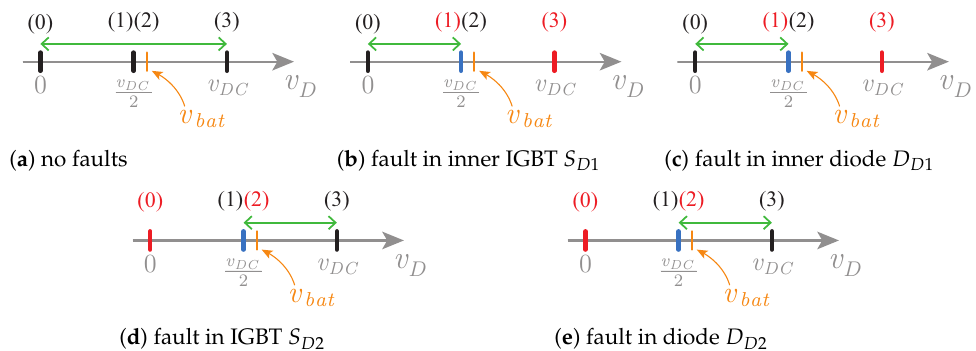
Figure 7. Available converter switching states and operating area of the 3LDC converter, in differ- ent conditions: ( a ) normal operation; ( b – e ) with OC faults in different semiconductors (available modulation interval shown in green; unavailable switching states in red).